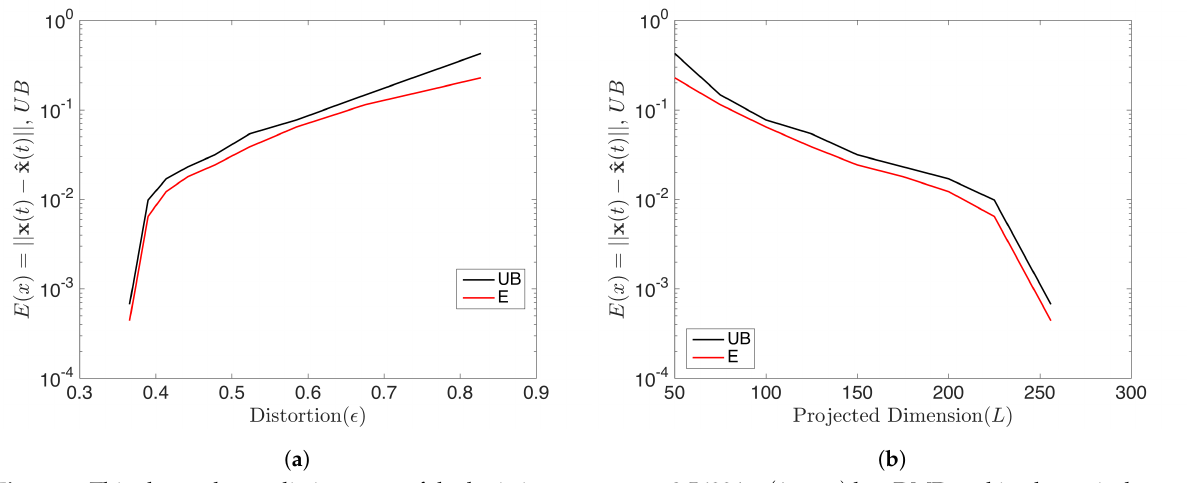
Figure 6. This shows the prediction error of the logistic map x n + 1 = 3.56994 x n ( 1 − x n ) by rDMD and its theoretical upper bounds(Equation (14)). ( a ) Represents the error with respect to the distortion (cid:101) and ( b ) shows the error with the dimension of the projected space that will guarantee the bound for this